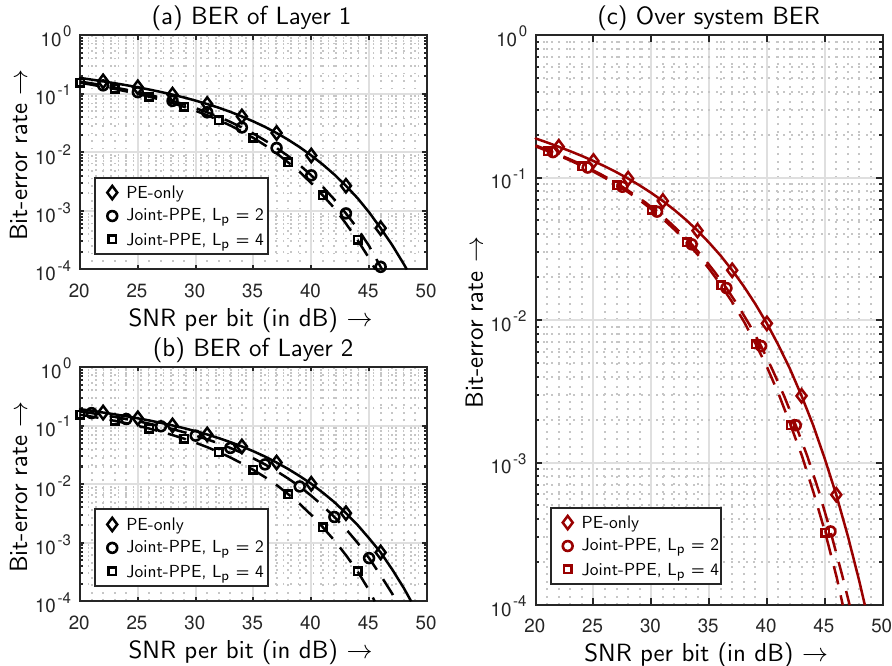
Figure 5. BER in dependent on SNR for the second scenario, where PAM-4 is utilized on both the MIMO inputs. The BER associated with PE-only and the proposed joint-PPE schemes are represented with solid and dashed lines respectively.